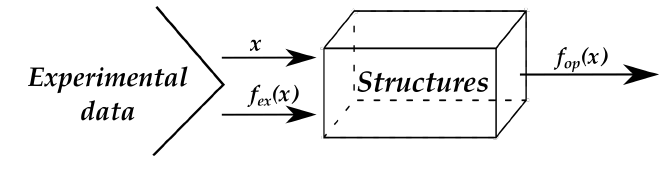
Figure 1. Flow of optimization